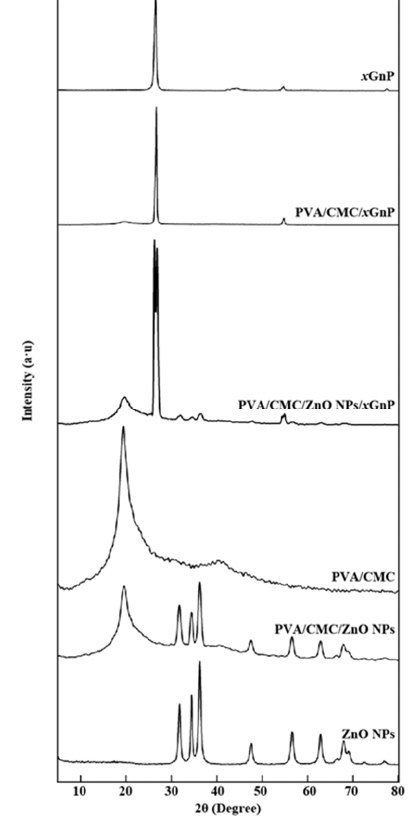
Figure 5. XRD (X-Ray Diffractometry) patterns of ZnO NPs, x GnP, the pure PVA/CMC film, PVA/CMC/ZnO NPs, PVA/CMC/ x GnP, and the PVA/CMC/ZnO NPs/ x GnP (ZnO NPs: x GnP = 7:3) composite film (ultrasonication time, 30 min).